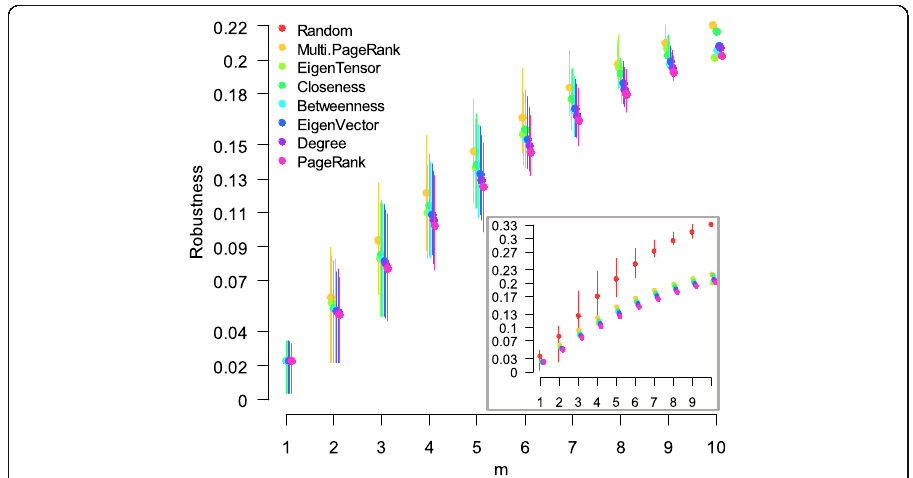
Fig. 5 Robustness of multiplex networks of reptile trafficking in Colombia. The resistance to targeted network attack is shown across all levels of plex combination (m) for different disruption strategies based on node centralities and versatilities. Elements are slightly displaced in the x axis. Subpanel shows the average result of the strategies in comparison to random node-deletion interventions (i.e.